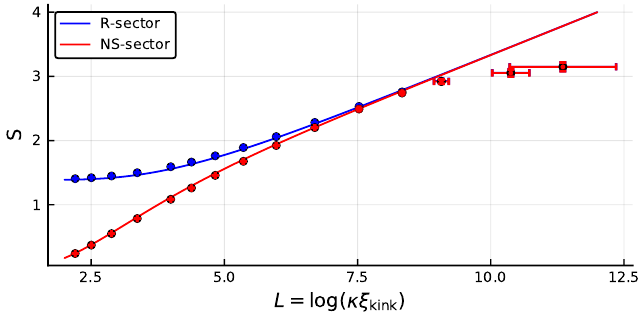
Figure 8 . The bipartite entanglement entropy along the different cuts as a function of the loga- rithmic length scale L . The error bars are calculated in a similar fashion to those in figure 3. The curves represent the entropies corresponding to the entanglement spectra predicted from entangle- ment hamiltonians eqs. (7.8) and (7.9). We find good agreement except for very large L ; this is due to ill converged MPS results, as was also the case in figure